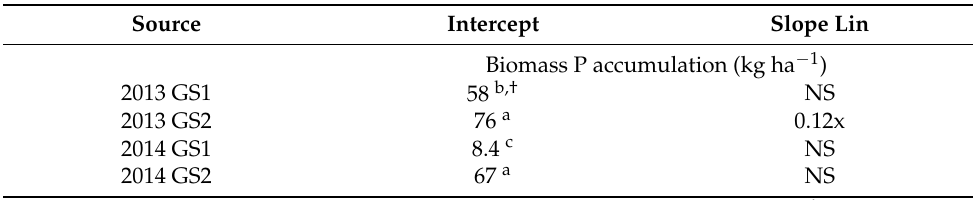
Table A6. Biomass P accumulation under incorporated-residue management as a function of P 2 O 5 rates, growth stages, and years (2013 and 2014).